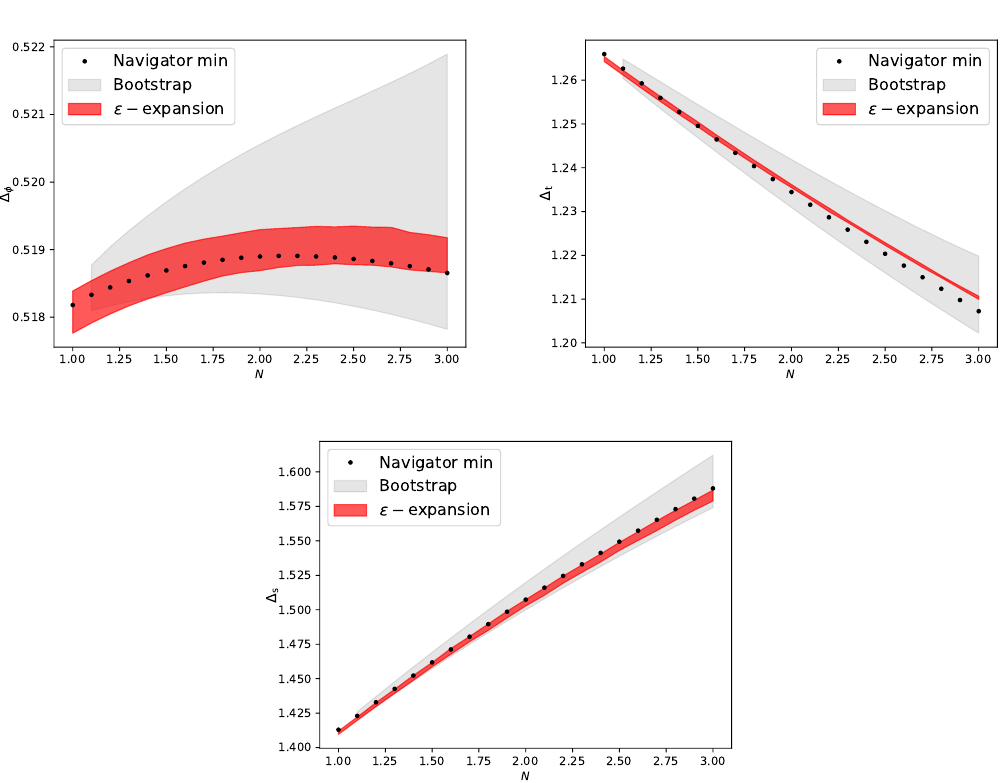
Figure 8: ∆ φ , ∆ and ∆ as functions of N , as determined by both the conformal s t bootstrap with the help of the navigator function, and from the resummation of 6- loop ε